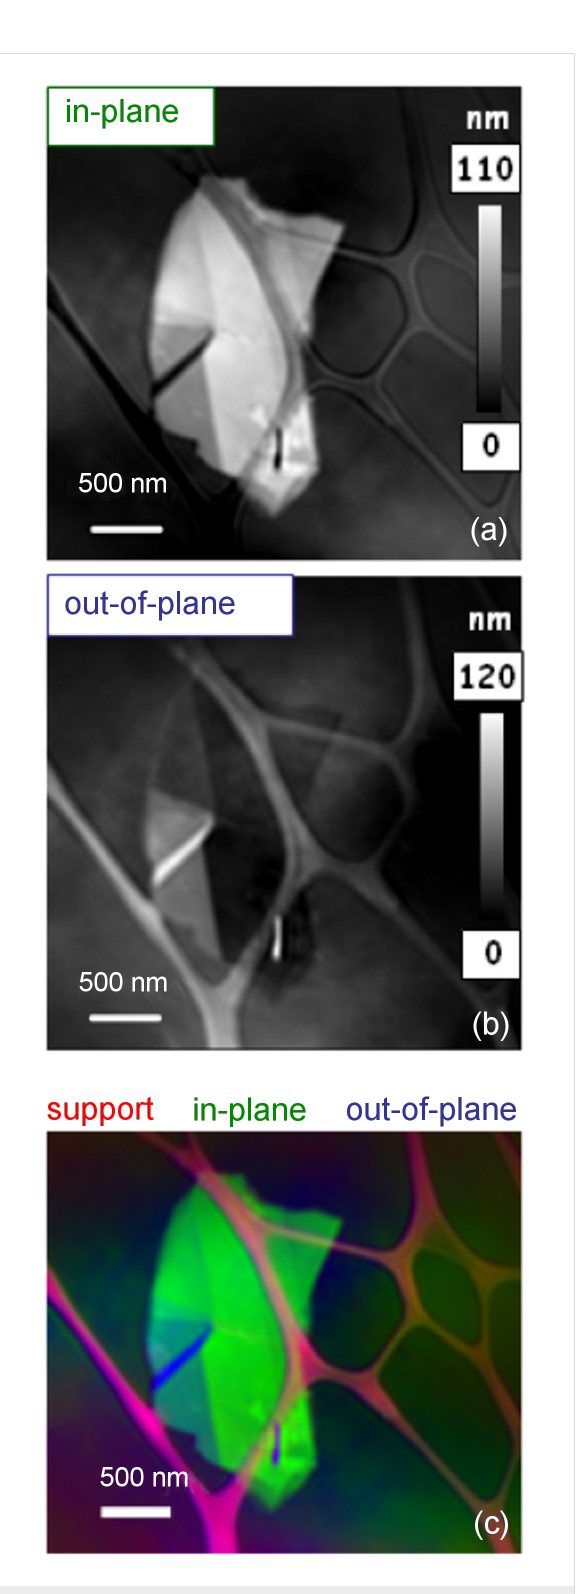
Figure 3: Component map of (a) in-plane ( σ ) and (b) out-of-plane ( π ) bonds; (c) colour-coded composite of the maps for lacey carbon (red), in-plane (green) and out-of-plane (blue), derived from a three- component fit of the carbon K-edge image